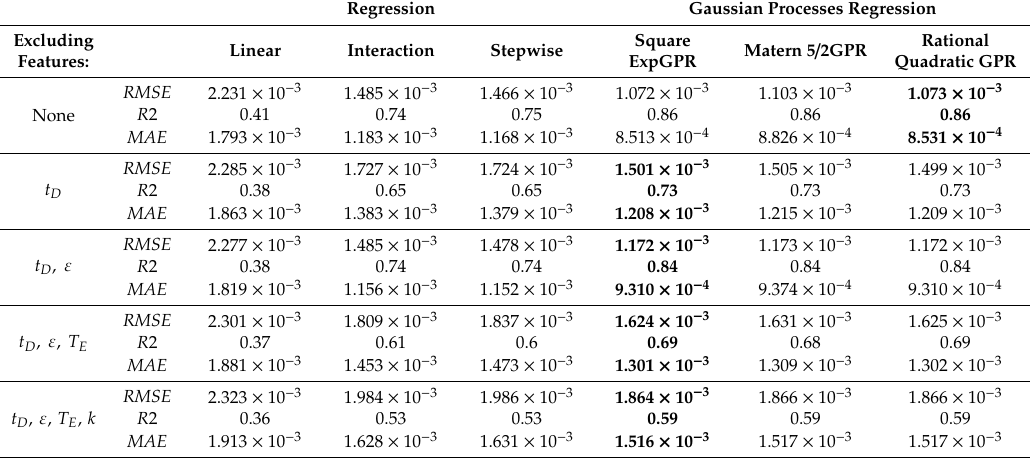
Table 7. Performance results for defect length predictor models using a dataset of 500 sets of values. Part 1: Regression and GPR when “Contrast Rear” is not contemplated as feature. The models with the best predictive performance are indicated in bold